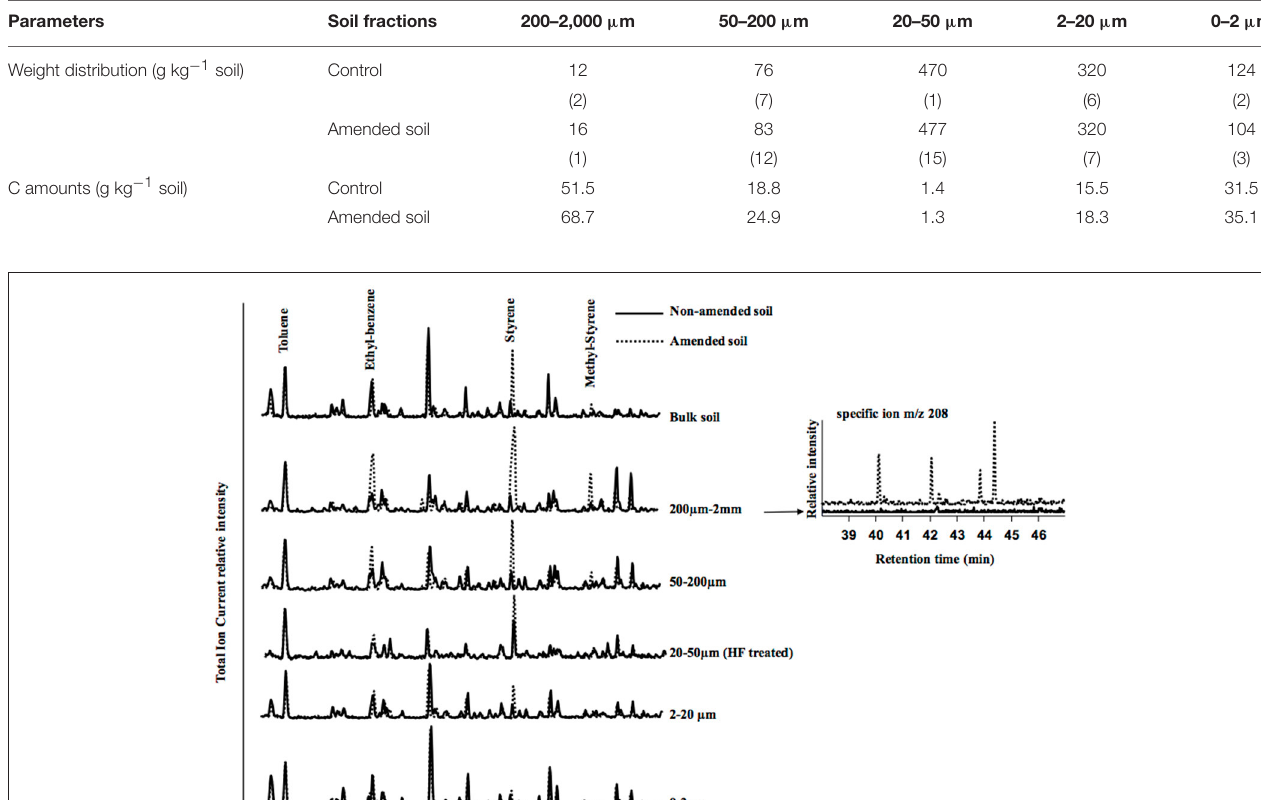
TABLE 5 | Weight distribution of granulometric fractions (g kg − 1 soil) expressed as the means of three replicates (standard errors in brackets) and C amounts in the soil fractions (g kg − 1 soil). Parameters